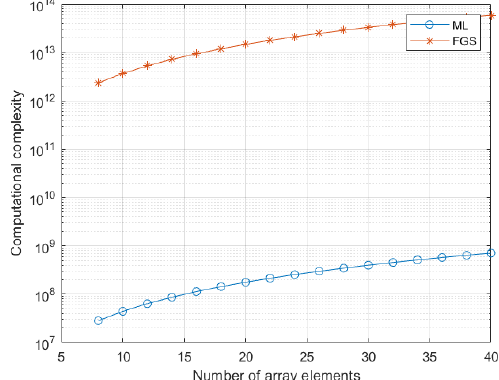
Figure 1. Computational complexities of the multi-dimensional maximum likelihood (ML) and fine grid-search (FGS) methods when the number of array elements varies from 8 to 40.